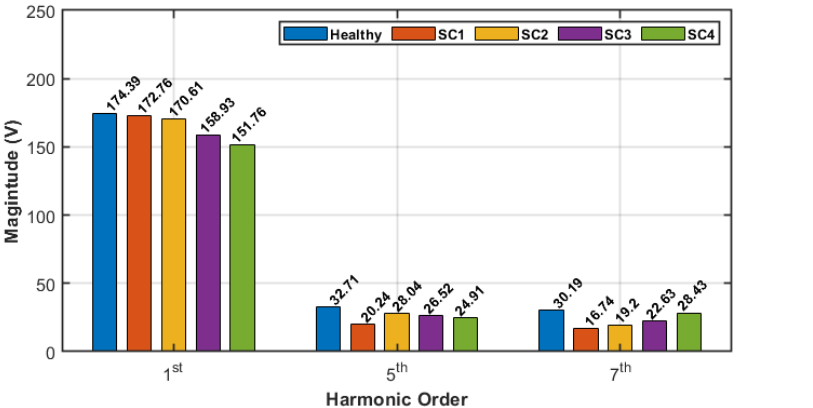
Figure 15. Variations in the harmonic content of stator voltage spectrum for healthy and faulty machine under TTSC fault in DTC drive.